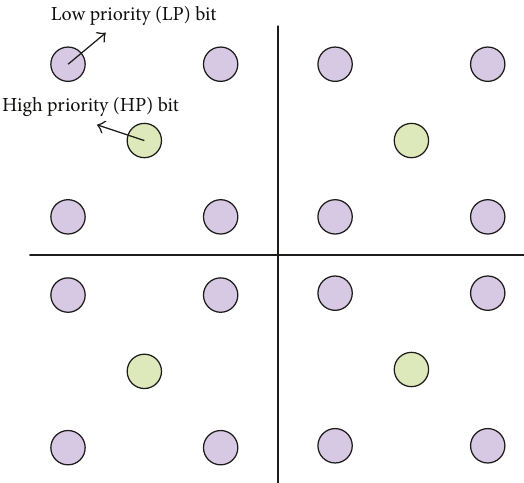
Figure 1: Hierarchical modulation of order